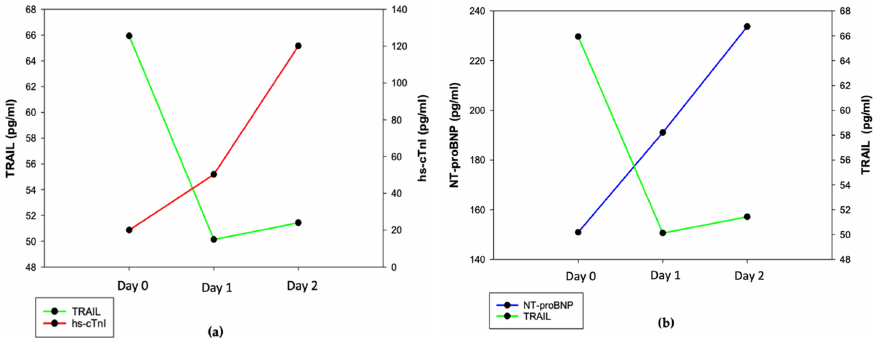
Figure 4. Relationship between TRAIL and markers of myocardial injury in patients after ICH. ( a ) Association between NT-proBNP and TRAIL; ( b ) association between TRAIL and hs-cTnI; mean values and SD: NT-proBNP day 0: 150.8 ± 143.4, day 1: 191.1 ± 158.9, day 2: 233.7 ± 276.8, TRAIL day 0: 65.9 ± 31.7, day 1: 50.1 ± 27.3, day 2: 51.4 ± 32.9, hs-cTnI day 0: 20.1 ± 23.9, day 1: 50.2 ± 87.8, day 2: